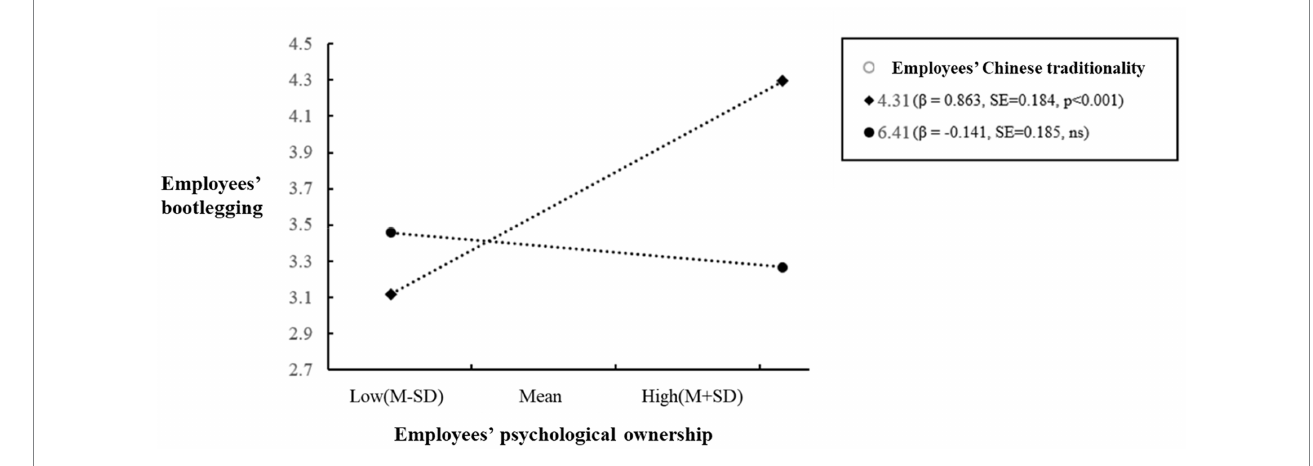
FIGURE 2 Moderating effect of Chinese traditionality on the relationship between psychological ownership and